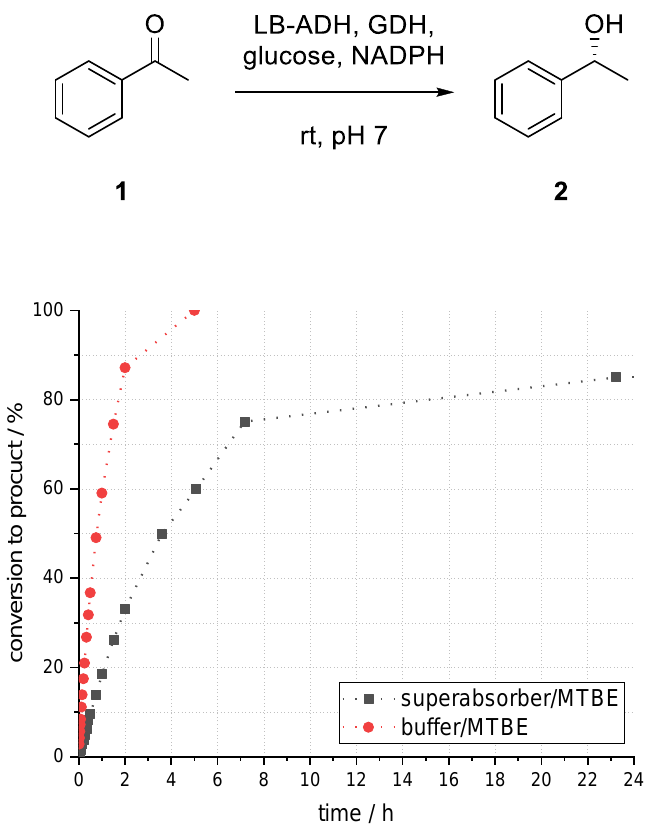
Figure 5. Comparison of enzymatic reduction of acetophenone ( 1 ) to phenylethanol ( R )- 2 using ADH in biphasic buffer/MTBE system versus superabsorber/MTBE system, both 1:5 (v/v).